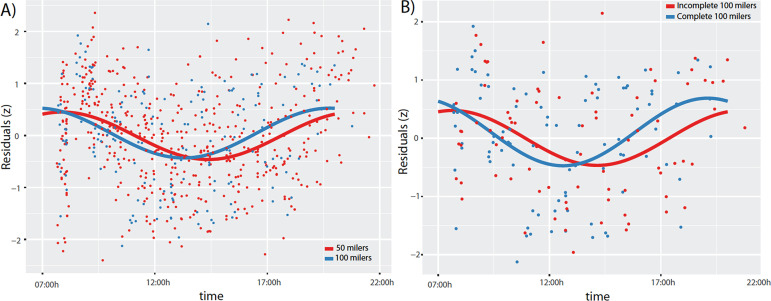
Cosinor fit to account for time-dependent differences in individual performance/speed for the first 50 miles of the race for (A) all 50- and 100-milers, and (B) only 100 miles. All ultramarathoners slowed in the early afternoon but sped up in the early evening. The acrophase of 100-mile runners (blue) was phase-advanced compared to 50-milers (red; A). The acrophase of runners who completed the 100 miles (blue, n=9) was phase-advanced compared to those who could not complete the 100 miles (red, n=8; B).